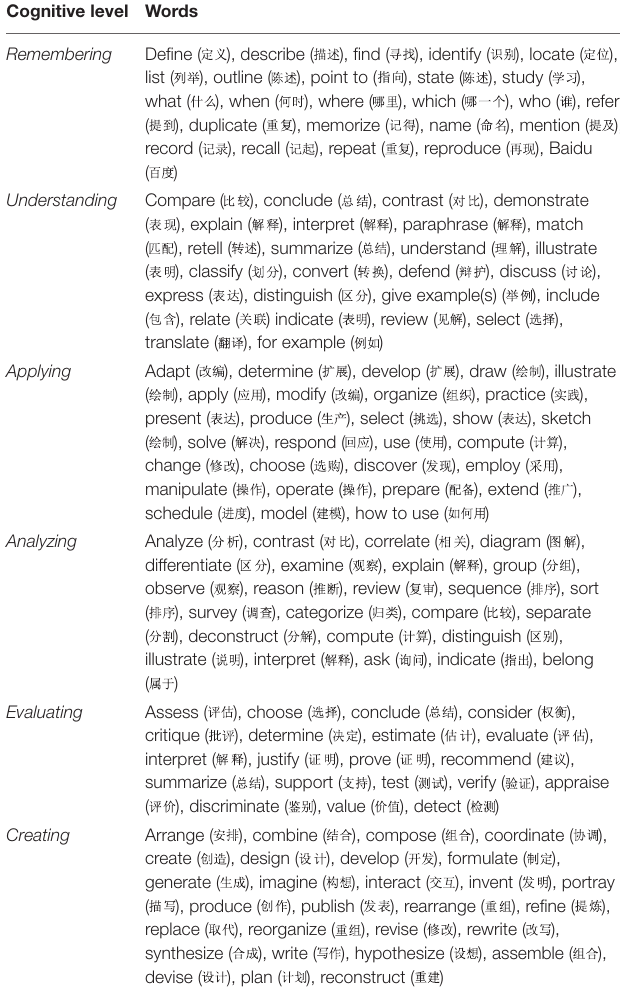
TABLE 5 | Words with high attention. Cognitive level